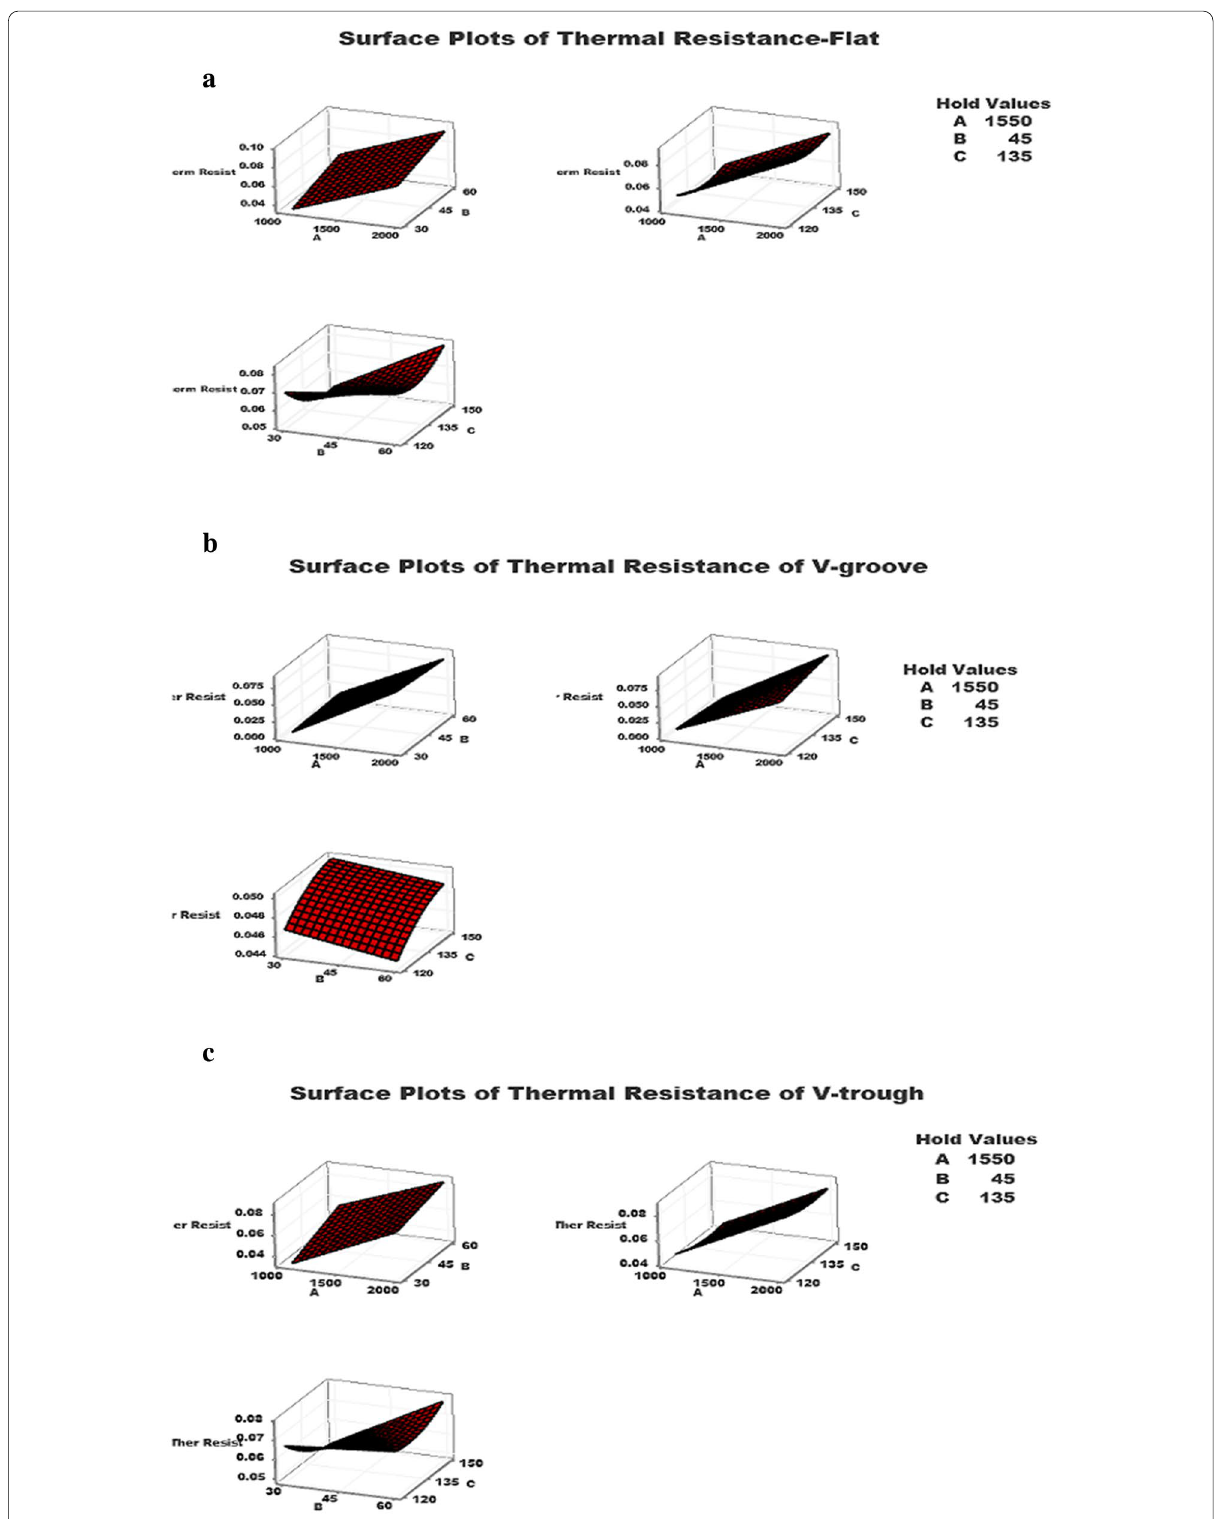
Fig. 6. 3-D surface diagram of thermal resistance for ( a ) flat, ( b ) V-grooved, ( c ) V-trough absorber